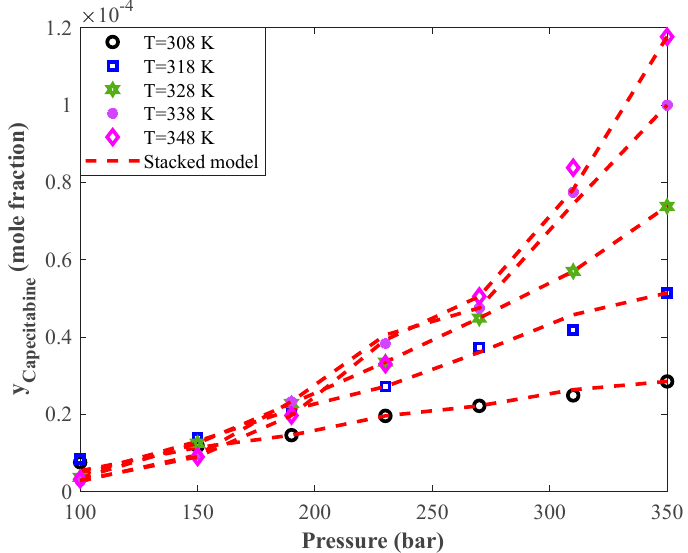
Figure 6. Monitoring the effect of pressure on the anticancer drug (Capecitabine) solubility in supercritical CO 2 from the laboratory and modeling perspectives.